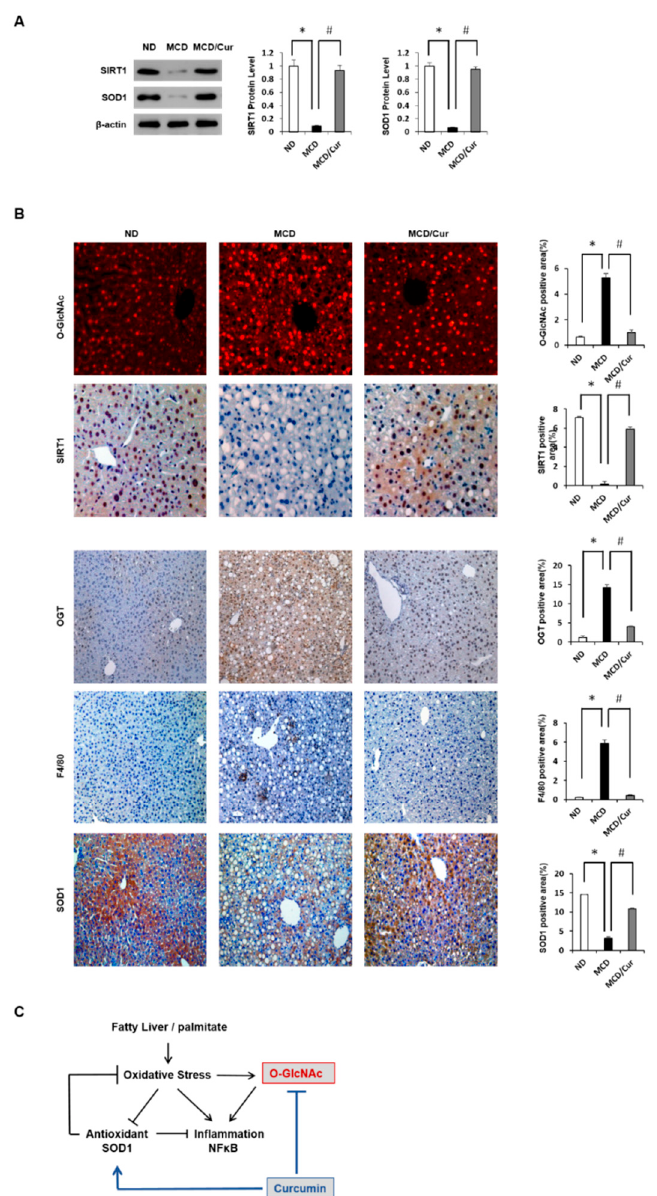
Figure 6. Curcumin prevents inflammation by inhibiting O -GlcNAcylation and activates antioxidant proteins. ( A ) Liver lysate was prepared from mice fed with ND, MCD diet, or MCD/curcumin (100 mg/kg) diet. Hepatic expression levels of SIRT1 or SOD1 were measured by immunoblot analysis. The levels of proteins were normalized to endogenous β -actin protein for each group. The relative amounts of